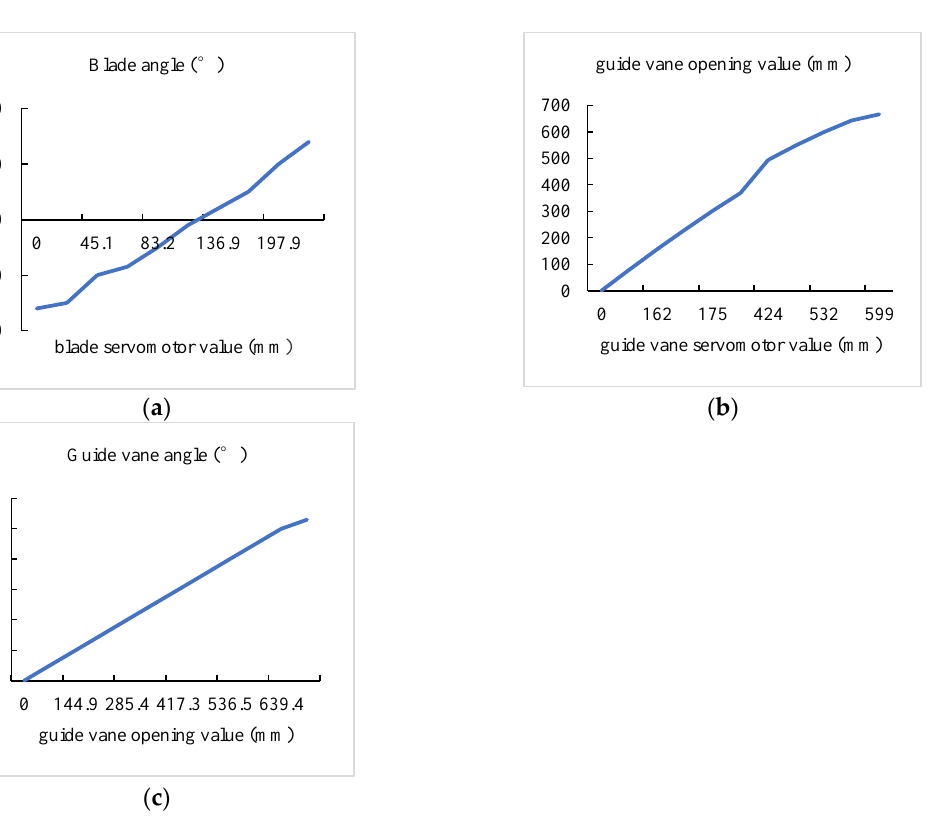
servomotor value and guide vane opening value ( b ), guide vane opening value and guide vane angle ( c ).